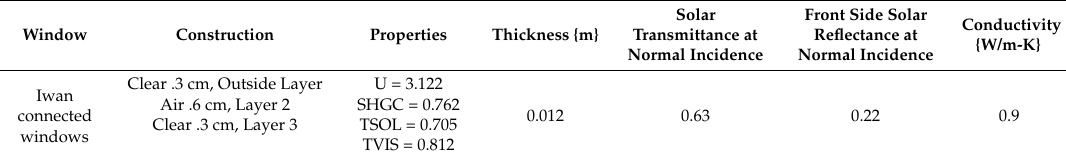
Table 5. The thermal characteristics of